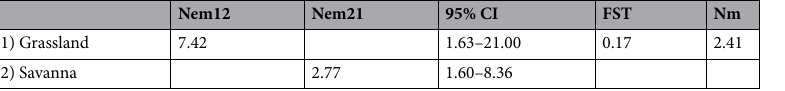
Table 5. Most probable estimates of migrants per generation between local populations of D.vittatus belonging to Savanna and Grassland Biomes based on Bayesian (Nem ij ) and traditional FST approaches (Nm) between local areas belonging to Savanna and Grassland Biomes in Argentina.